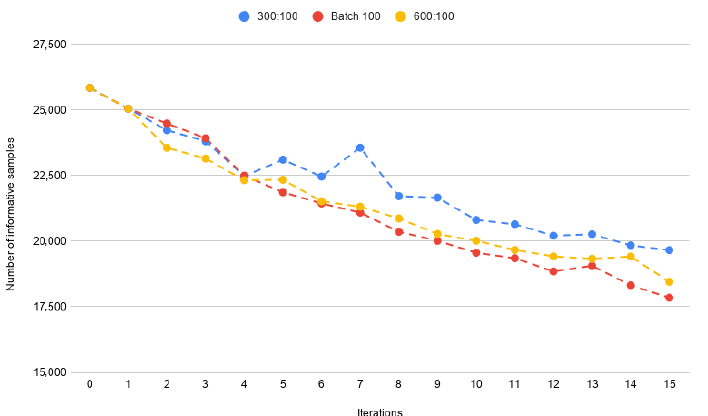
Figure 12. Number of informative samples for batch 100, 300:100, and 600:100 networks.